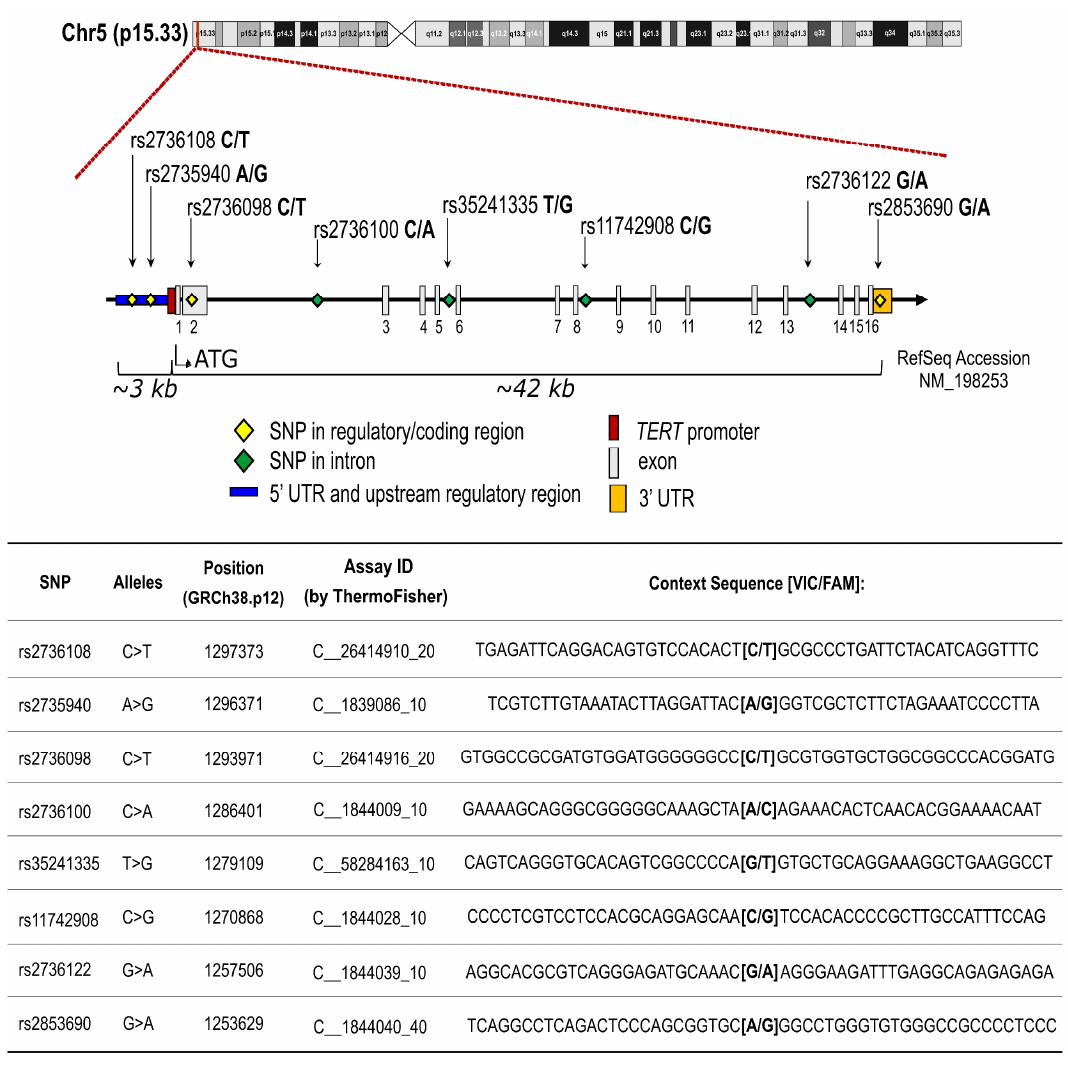
Figure 1. Schematic illustration and characteristics of selected SNPs within TERT gene.